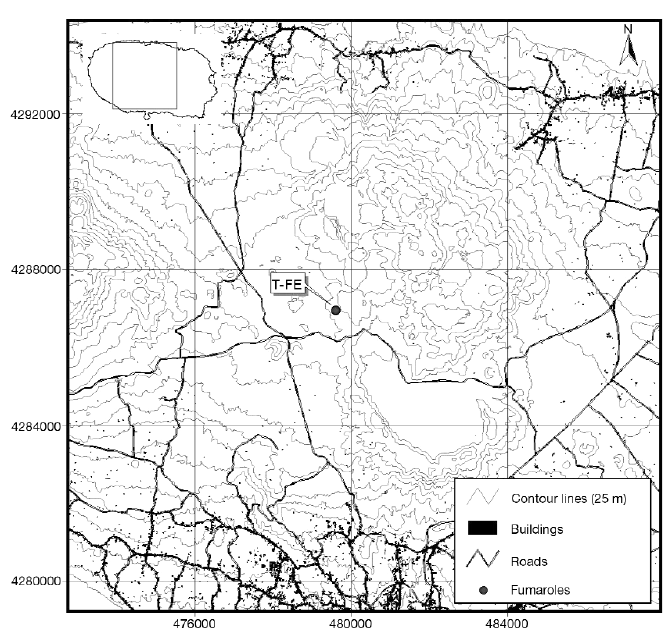
Fig. 4. Furnas do Enxofre fumarolic field at Terceira Island (T-FE – Furnas do Enxofre).